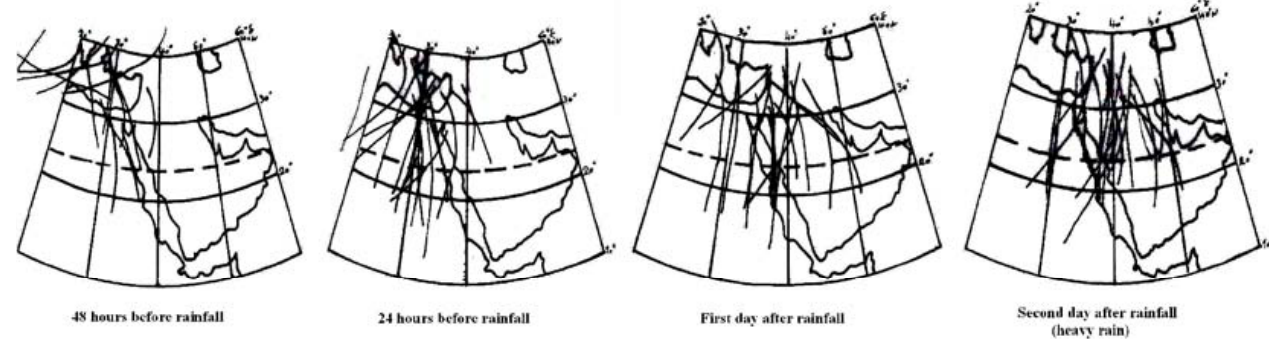
Fig. 21 The mean positions of 1015 hPa isobars of the 20 selected floods, two days